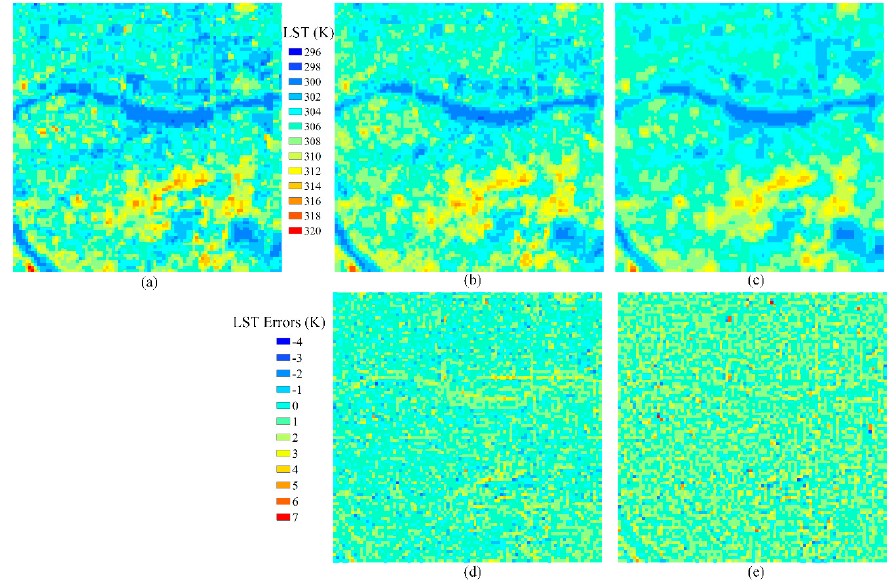
Figure 4 . Spatial distribution of LSTs in region A. ( a ) 90 m ASTER LST; ( b ) 90 m downscaled RFATPK LST; (c) 90 m downscaled TsHARP LST; ( d ) 90 m errors between ASTER and RFATPK LSTs; and ( e ) 90 m errors between ASTER and TsHARP